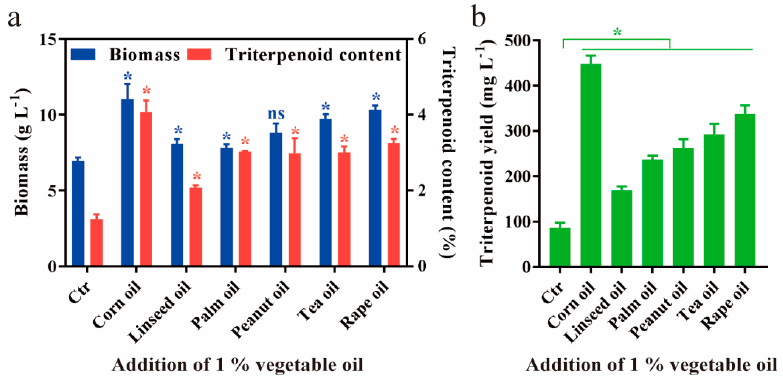
Figure 1. Effects of various vegetables oil on the fermentation of A. cinnamomea . Biomass and triterpenoid content ( a ), and triterpenoid yield ( b ), are quantitatively analyzed, respectively. The addition volume of various vegetable oils is 1% ( v/v ). The control has no vegetable oils. All fermentations are conducted at 28°C for 12 days. All data are from triplicates (means ± SD). Asterisks denote ( * p < 0.05) statistically significant differences between the treatment groups and the control; ns indicates no significant difference.